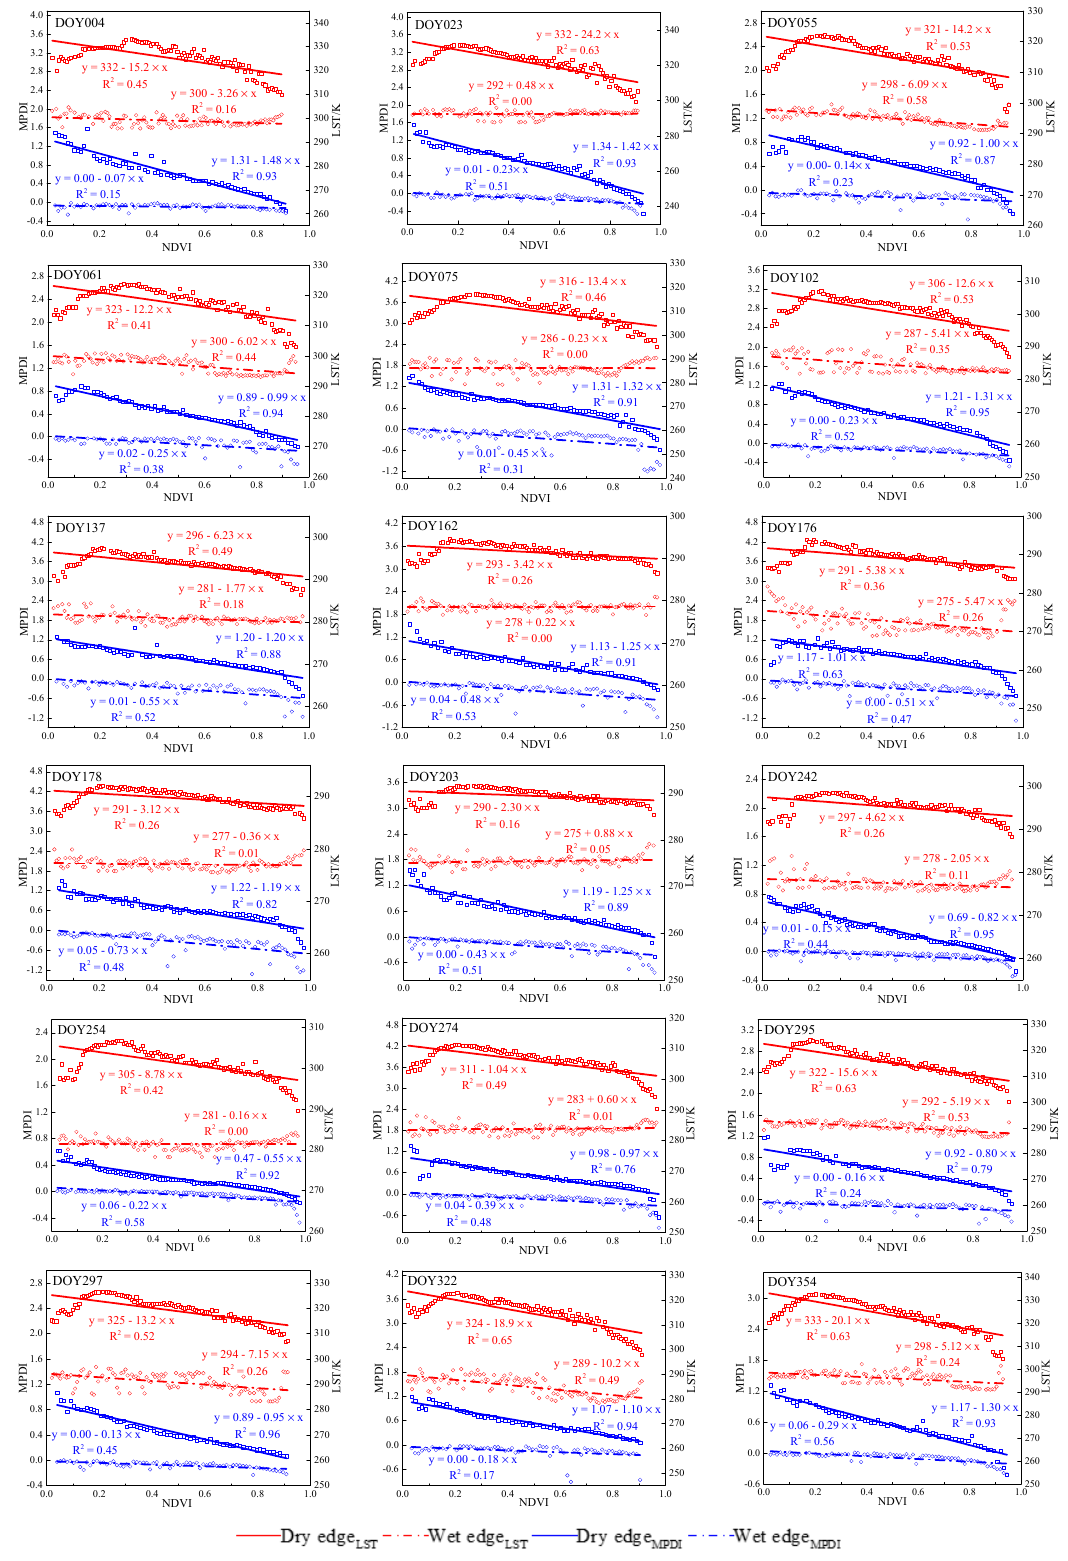
Figure 5. Scatterplots of dry and wet edges in the MPDI-NDVI and land surface temperature (LST)-NDVI feature spaces for 18